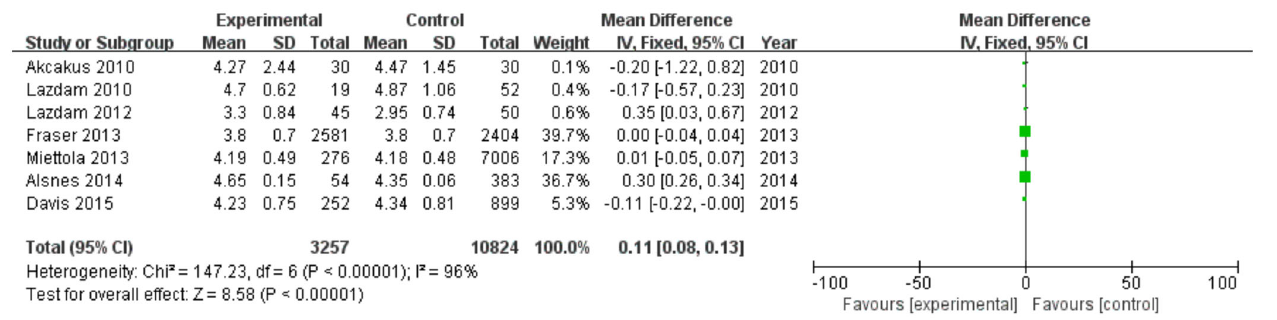
Figure 4. Meta ‐ analysis forest map for total cholesterol of offspring of PE pregnancies. Akcakus 2010